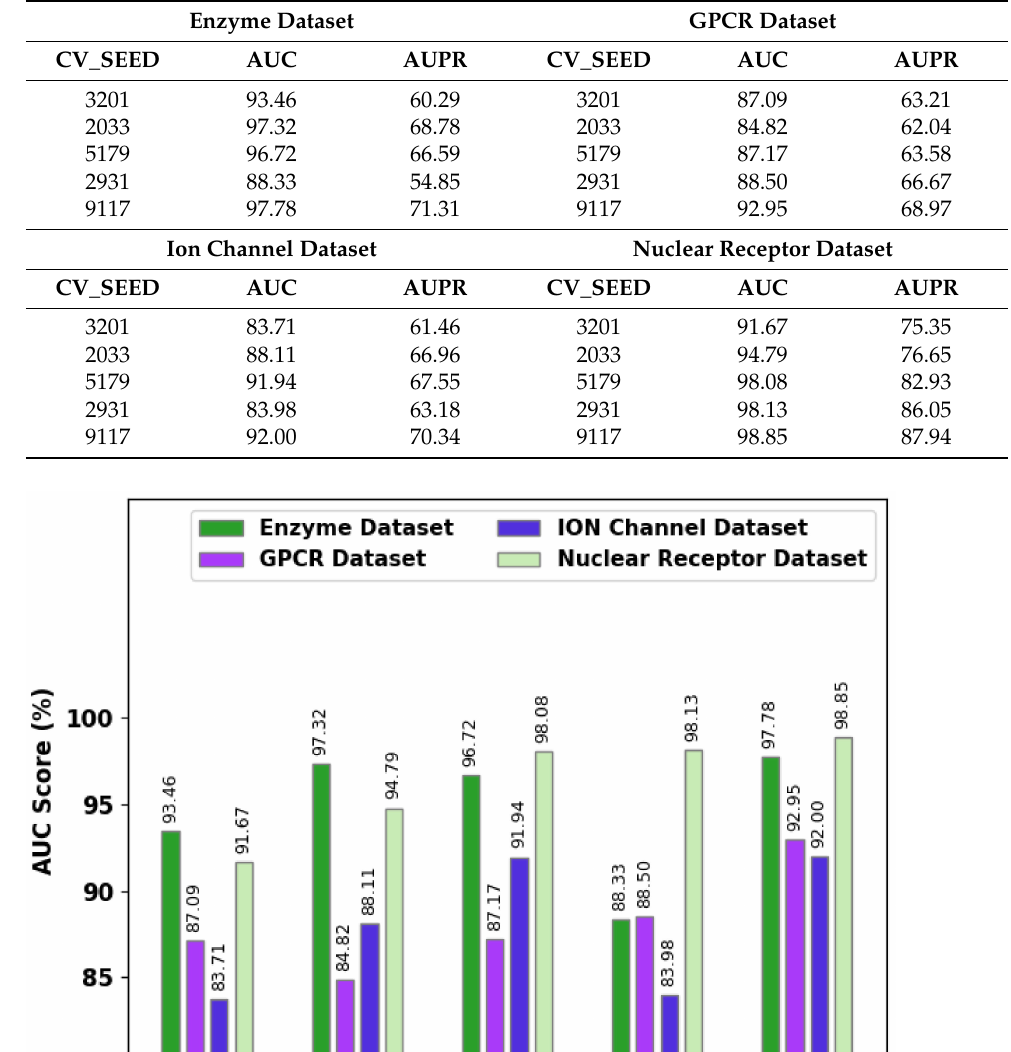
Table 3. AUC and AUPR analysis of the SSODL-DDIP system under distinct datasets.